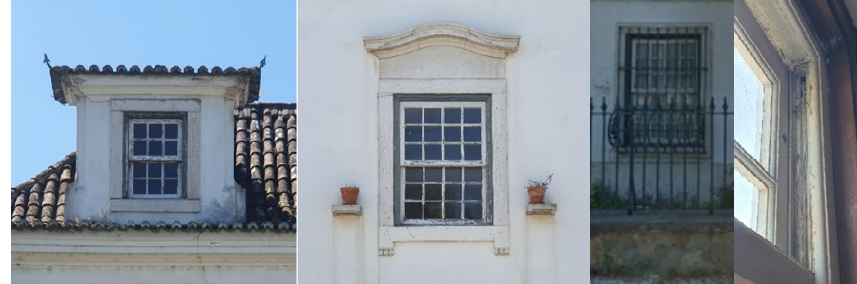
Figure 13. Distinct type of guillotine windows present in the main façade.